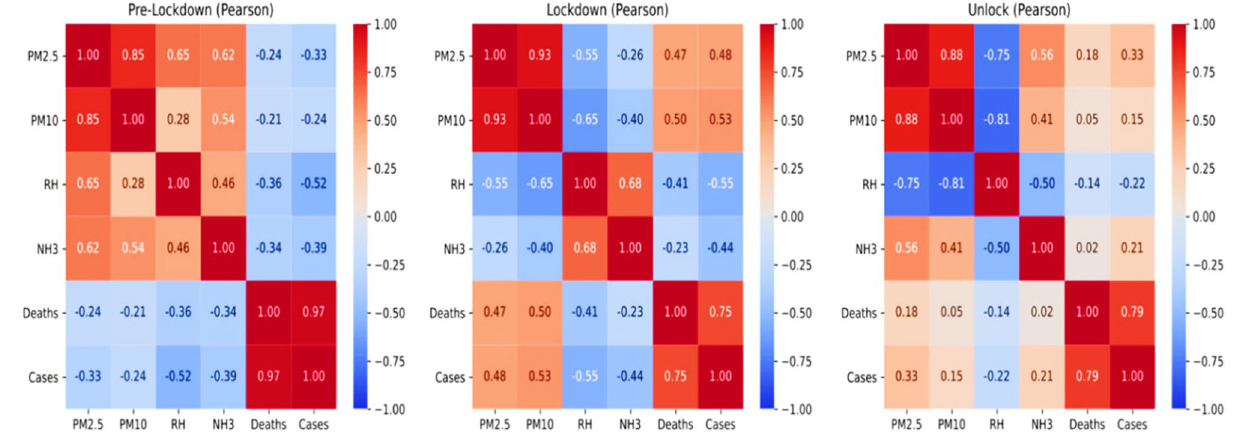
Figure 8. Pearson correlation plots amongst different variables, including environmental risk factors and COVID-19 severity for pre-lockdown phase, lockdown phase, and unblock phase.